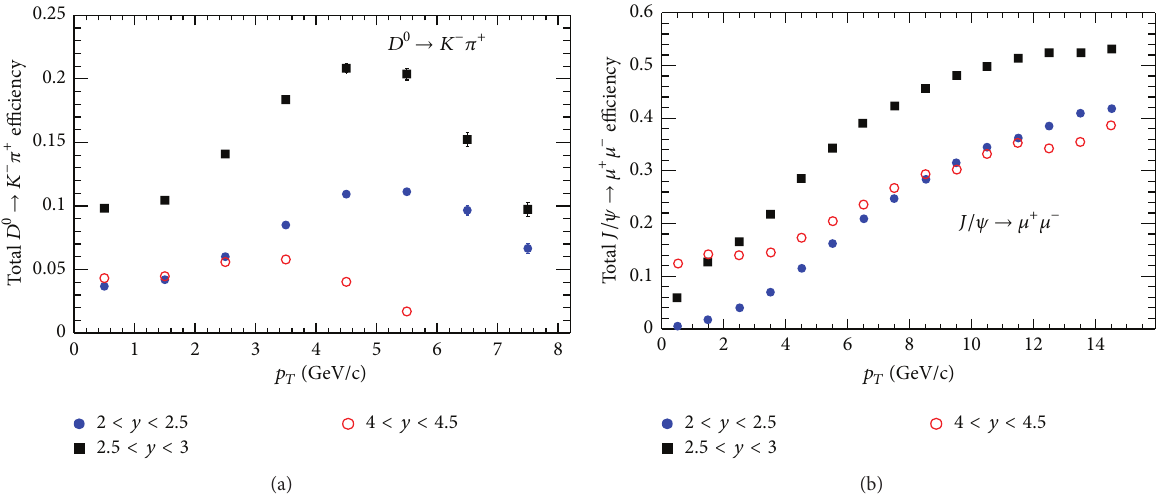
Figure 2: Total reconstruction efficiency for (a) 𝐷 0 [13] and (b) 𝐽/𝜓 [14] in the LHCb